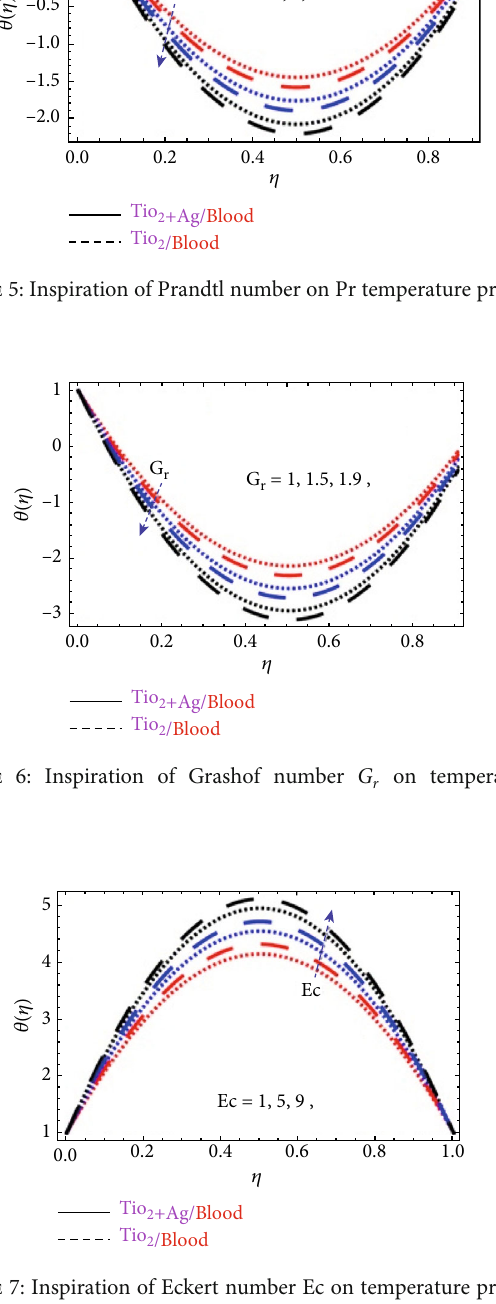
Figure 7: Inspiration of Eckert number Ec on temperature pro fi le.